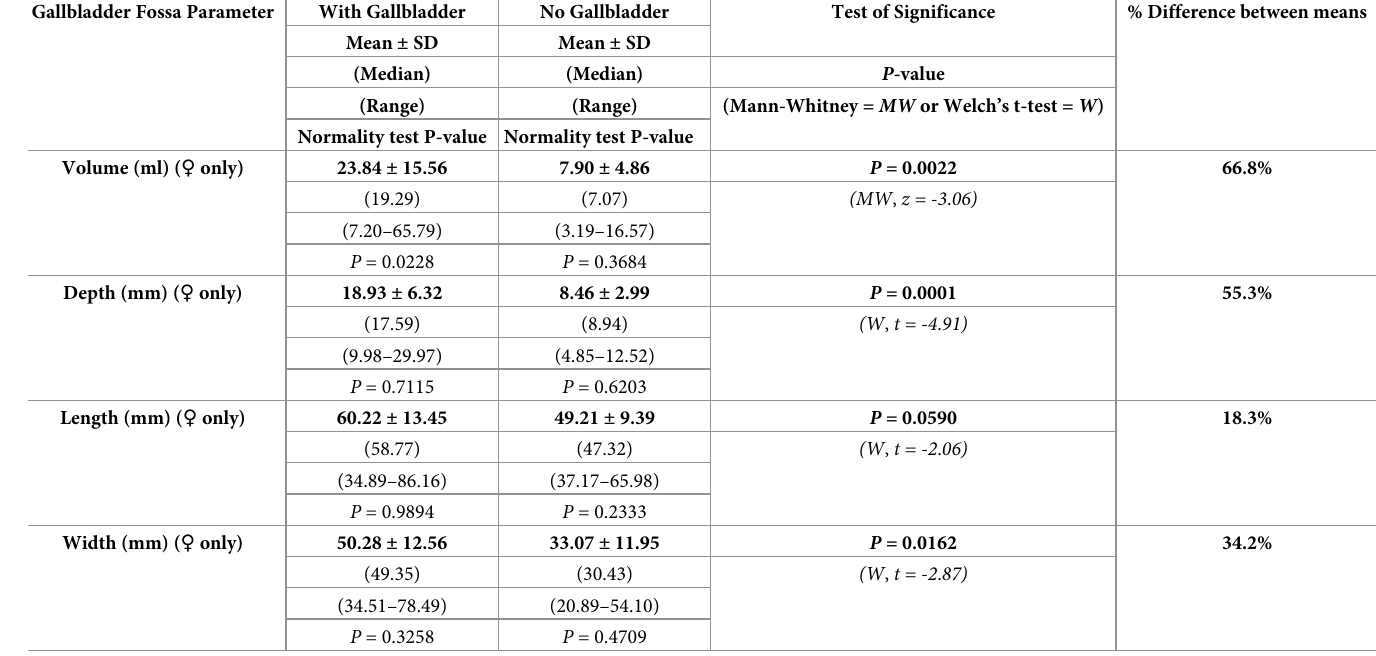
Table 4. Comparison of gallbladder fossa parameters in livers from female cadavers with and without gallbladders. Gallbladder Fossa Parameter With Gallbladder No